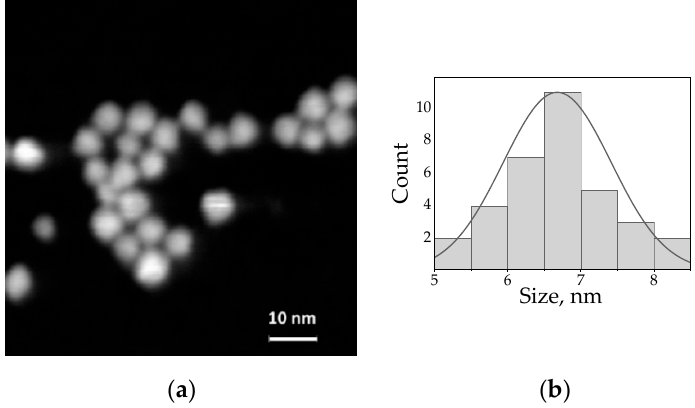
Figure 1. ( a ) STEM image of the water-soluble AIS/ZAIS/ZnS QDs; ( b ) Size distribution of the AIS/ZAIS/ZnS QDs (the mean diameter is 6.7 ± 0.8 nm).